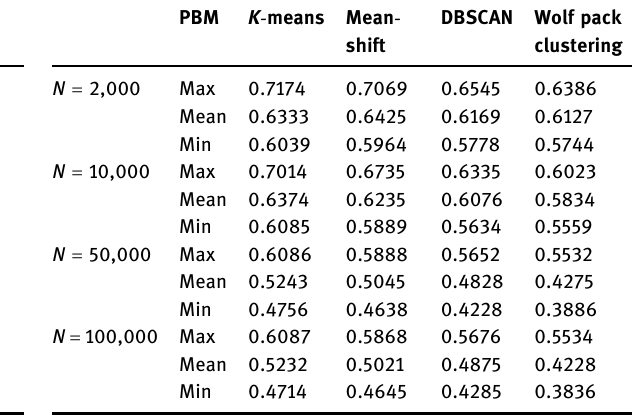
Table 3: DB performance with di ff erent sample sizes when P = 10